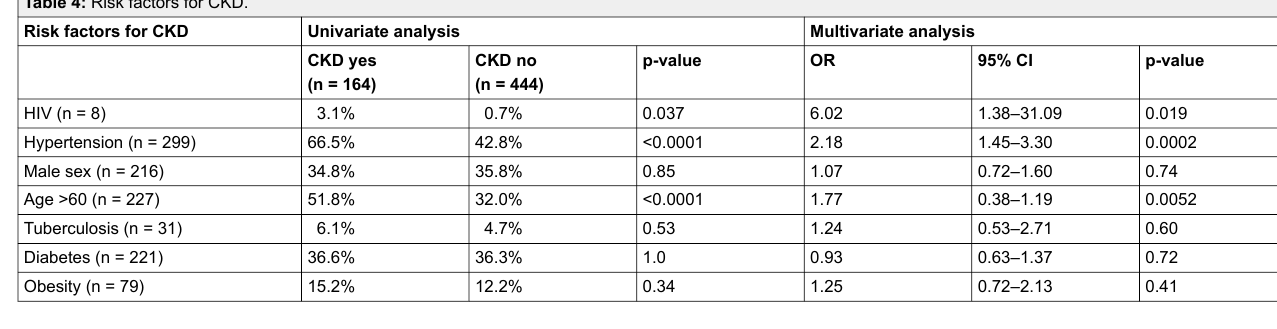
Table 4: Risk factors for CKD.